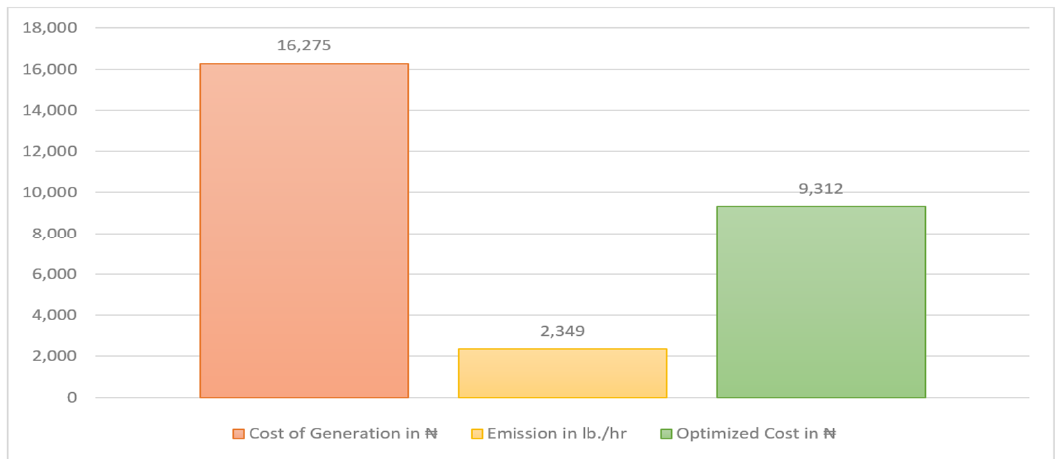
Figure 9. Case 4: Power output variation from diesel, PV and wind turbine generators.